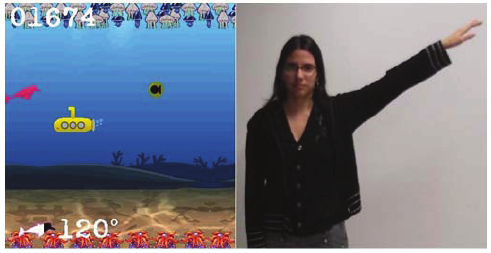
Figure 8. User’s body is tracked and the patient is required to practice a specific movement of interest in his/her treatment. Then the movement is evaluated by the system and a correction suggested when